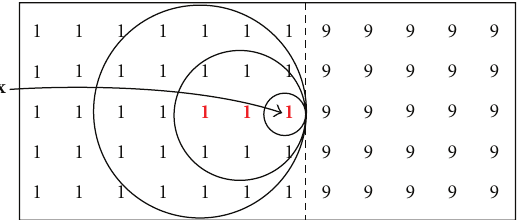
Figure 6: Image with noise. Pixel x is deterred from extending its sphere across the boundary because its mean is an outlier in the population S − 1 ( y